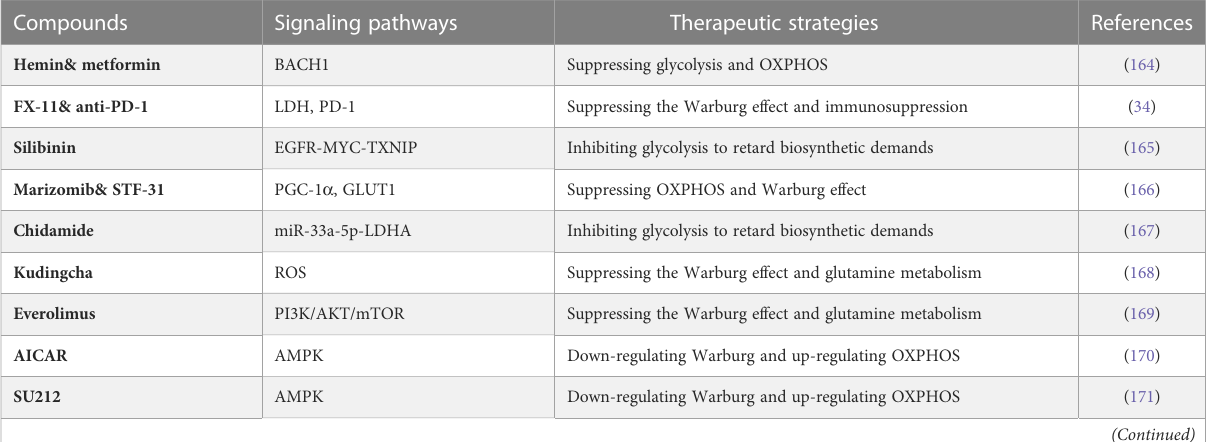
TABLE 2 Compounds targeting the Warburg effect in